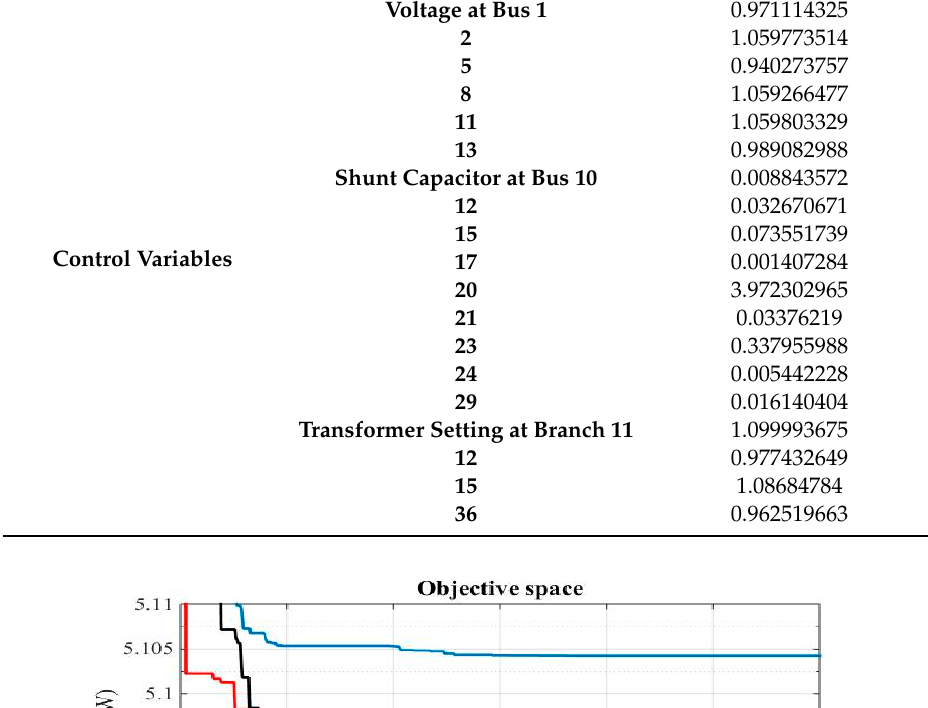
Table 4. 30-bus system decision variables for the second case.